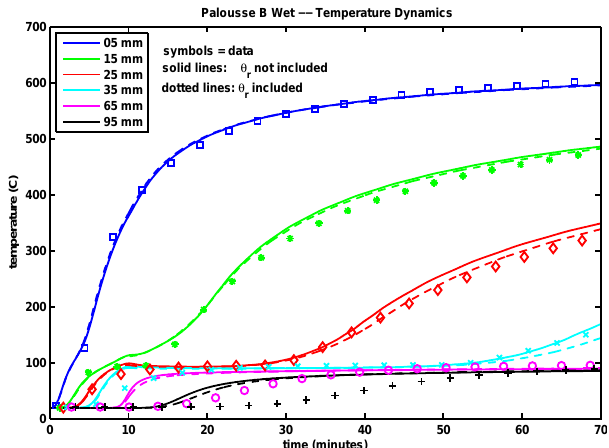
Figure 9. Example of the hydraulic conductivity, K H , and magni- tude of the hydraulic diffusivity, | K n | , as functions of soil moisture, θ , for the Quincy Sand R p = 1mm scenario. K H corresponds to the HCF for capillary flow from Assouline (2001), Eq. (17), and the model for film flow from Zhang (2011), Eq. (18). Numerically | K n | is just a rescaling of K H (see Sect. 2.2.5 for further details) and | K surf n | is derived from the model for V θ, surf from Gawin et al. (1999) (again see Sect. 2.2.5).